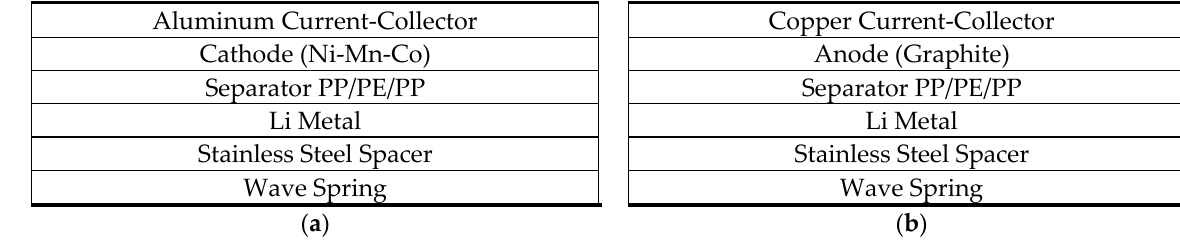
Figure 3. Schematic representation of materials mixed in ( a ) cathode and ( b ) anode. Four coin-cell type half-cells were assembled using the anodes and cathodes made from recycled materials along with half-cells made from new electrode material. Half-cell components and coin-cell assembly can be seen in Figure 4. Coin-cells were assembled by placing punched cathodes or anodes, polypropylene (PP)/polyethylene (PE)/polypropylene (PP) tri-layer separator, then Li metal chip in coin-cell casings along with a wave spring. Each half-cell was tested at two C-rates of C/5 and C/10.